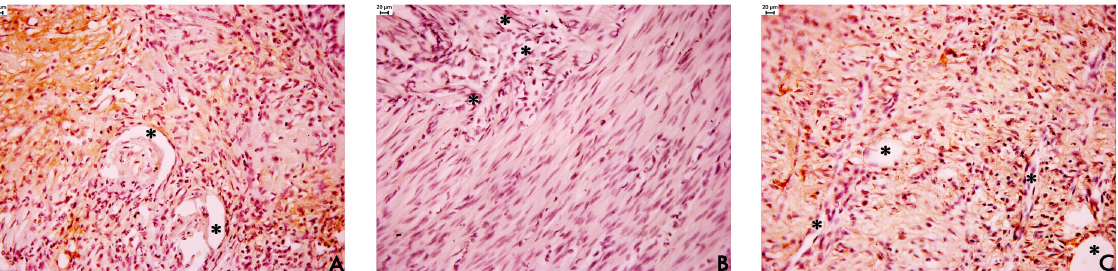
Figure 4. Photomicrographs submucosa from the stomach of rats subjected to different treatments. ( A ) vehicle (10 mL/kg); ( B ) cimetidine (100 mg/kg); and ( C ) ethyl acetate fraction of Alchornea triplinervia (100 mg/kg) immunostained for evidence of